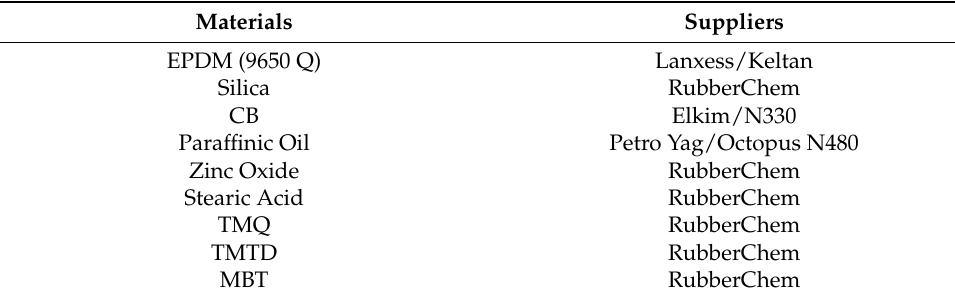
Table 1. Information on materials used in this study.